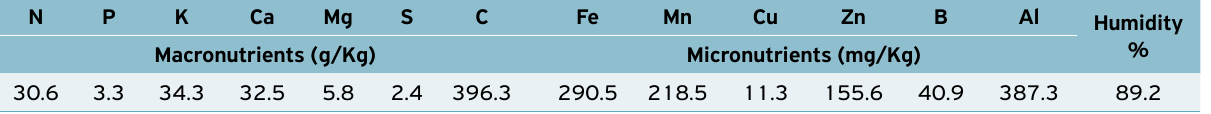
Table 2. Mineral composition (macro and micronutrients) of the kale plants used. N P K Ca Mg S C Fe Mn Al Humidity %Macronutrients (g/Kg)